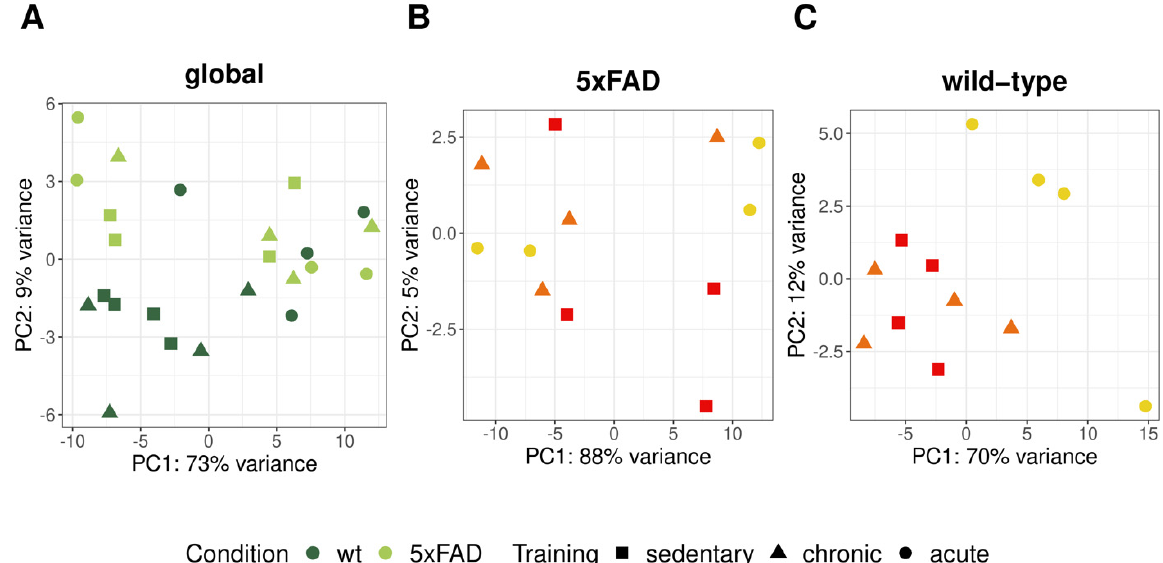
Figure 5. Principal component analysis of normalized RNA counts from 5xFAD and wild-type mice after different training regimens. Using principal component analysis, the highest variances within the gene counts corresponding to principal component 1 (PC1) and principal component 2 (PC2) were calculated and plotted for ( A ) all ( n = 24), ( B ) 5xFAD ( n = 12), and ( C ) wild-type ( n = 12) mice. In ( A ), dark green dots represent wild-type samples, while light green dots correspond to 5xFAD mice. The shapes of the symbols and the colors in ( B , C ) show the different training groups (red + circle = acute, orange + triangle = chronic, and yellow + squares = sedentary). The corresponding legend is located on the bottom.